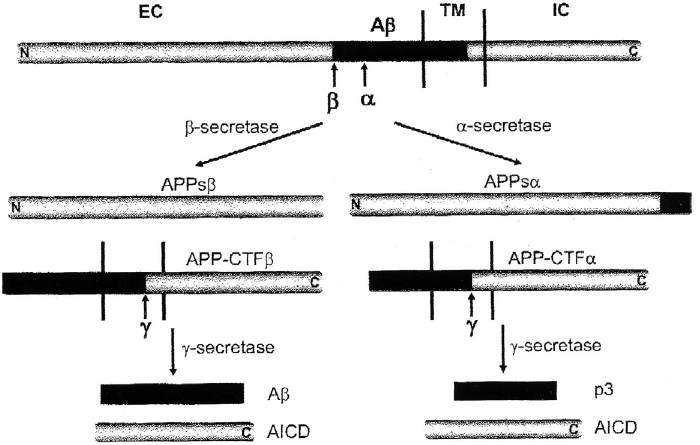
Figure 2: Schematic diagram of APP processing pathways (not drawn to scale). The A β domain is highlighted in black. For simplicity, only one cleavage site is shown for each enzyme. EC, extracellular domain; TM, trans- membrane domain; IC, intracellular